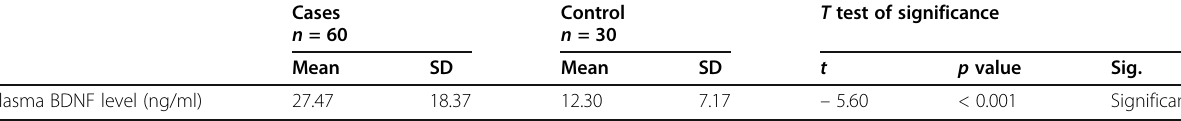
Table 3 Comparison between the two studied groups regarding plasma BDNF